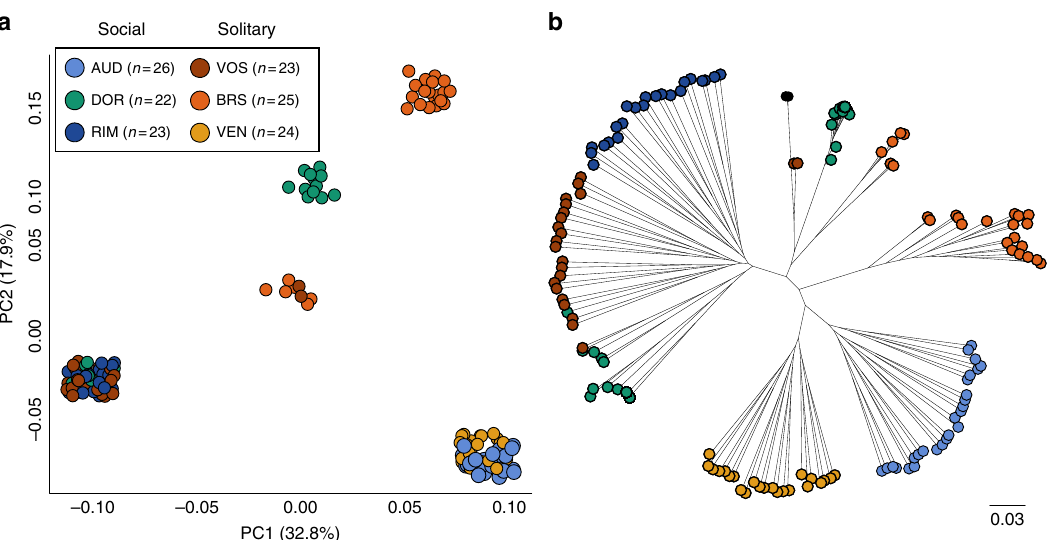
Fig. 2 Repeated shifts in social behavior within L. albipes . a Genetic principal component analysis of six populations: three social (blues and greens) and three solitary (reds and oranges). b Population tree. Each dot represents an individual ( n = 143). Analyses were run using LD-pruned SNPs ( n = 688,836). Both the PCA and the population tree demonstrate that social and solitary forms are not incipient species; instead, the multiple groupings of social and solitary populations are consistent with repeated shifts in social behavior within L. albipes , likely the result of local